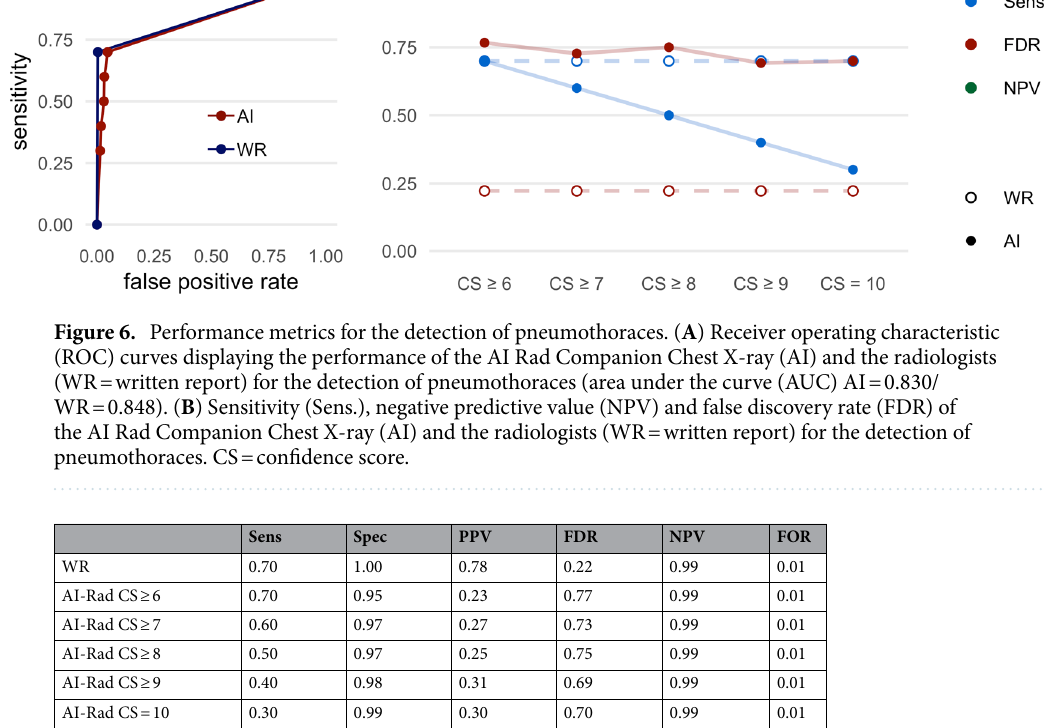
Table 6. Performance metrics of the radiologists (WR = written report) and the AI Rad Companion Chest X-ray (AI-Rad) for the detection of pneumothoraces. CS confidence score, PPV positive predictive value, NPV negative predictive value, FDR false discovery rate, FOR false omission rate.